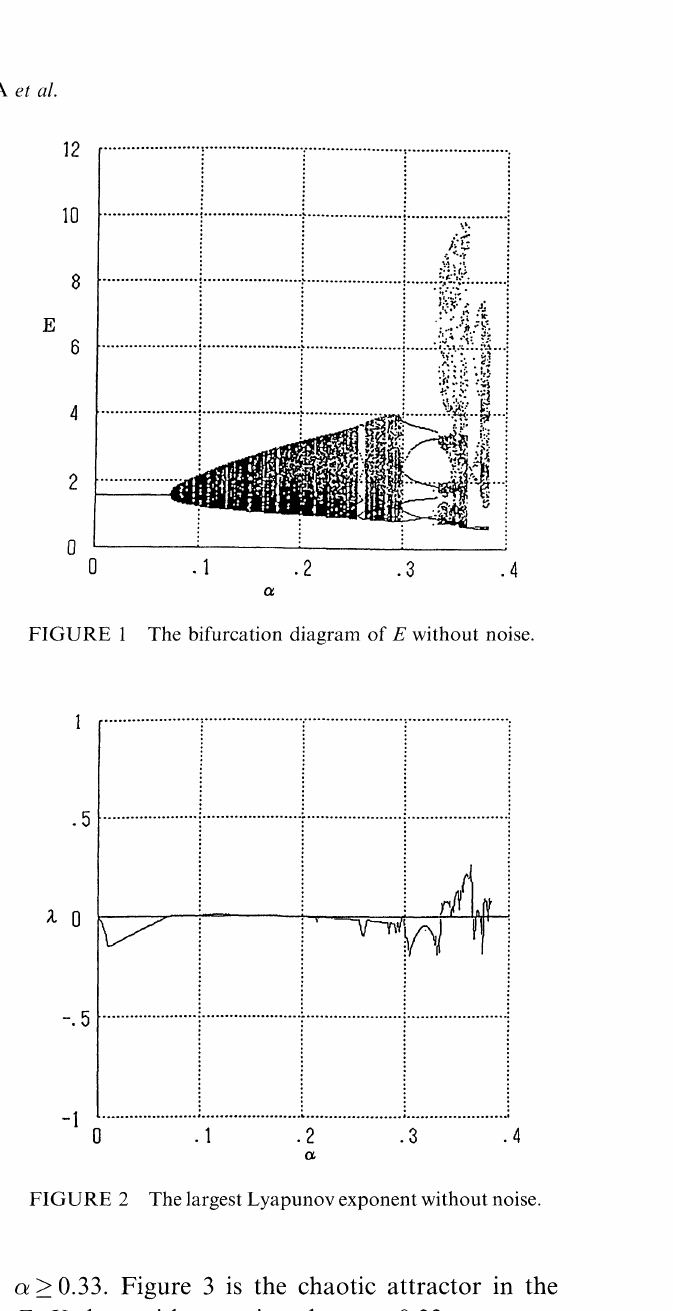
FIGURE 2 The largest Lyapunov exponent without